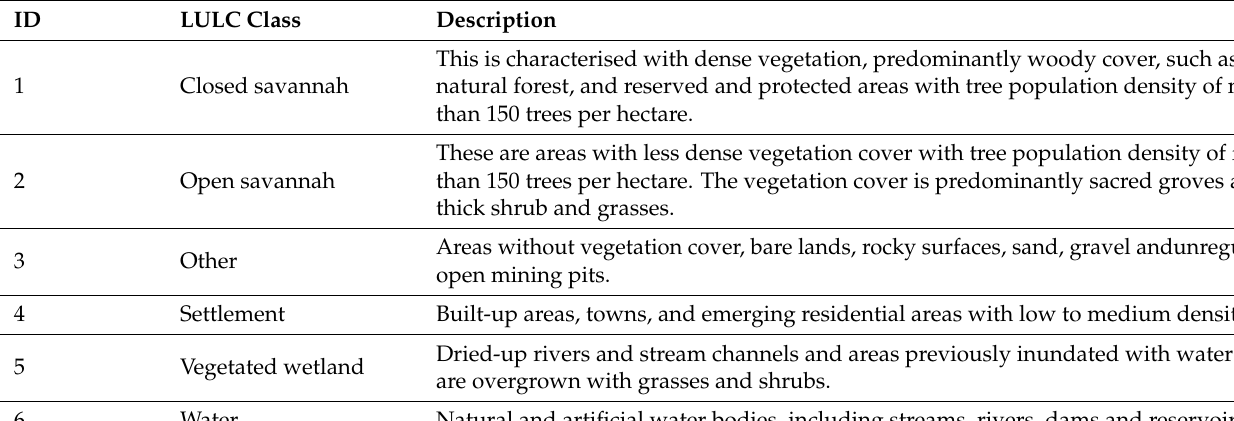
Table 3. Description of LULC classes of the